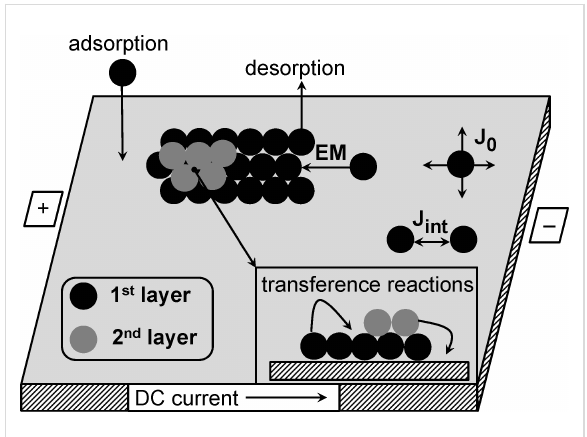
Figure 1: A schematic view of the two-layers model. Effects of upper layers are ignored in the model.